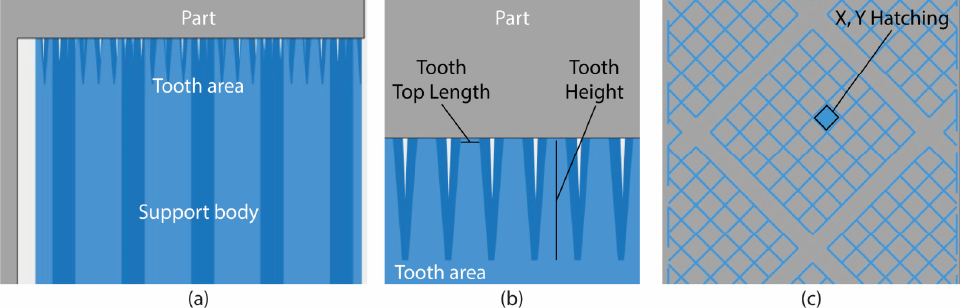
Figure 1. Block support structures: ( a ) Main body; ( b ) Tooth area; ( c ) Bottom view.